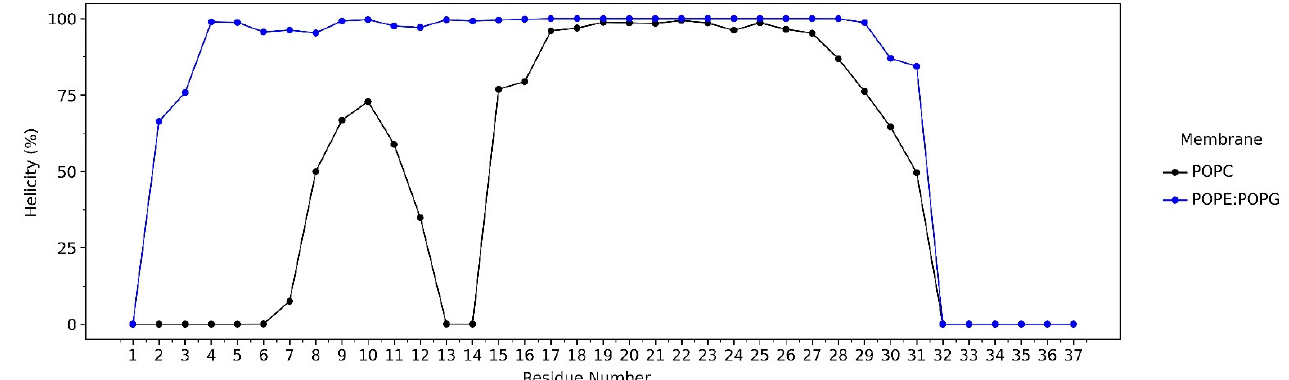
Figure 5. Secondary structure analysis of LL-37 during the 600 ns simulation. In general, LL-37 in the POPE:POPG system retains its helical conformation. The helicity percentage was calculated as the sum of α -helix and 3–10 helix occurrences.